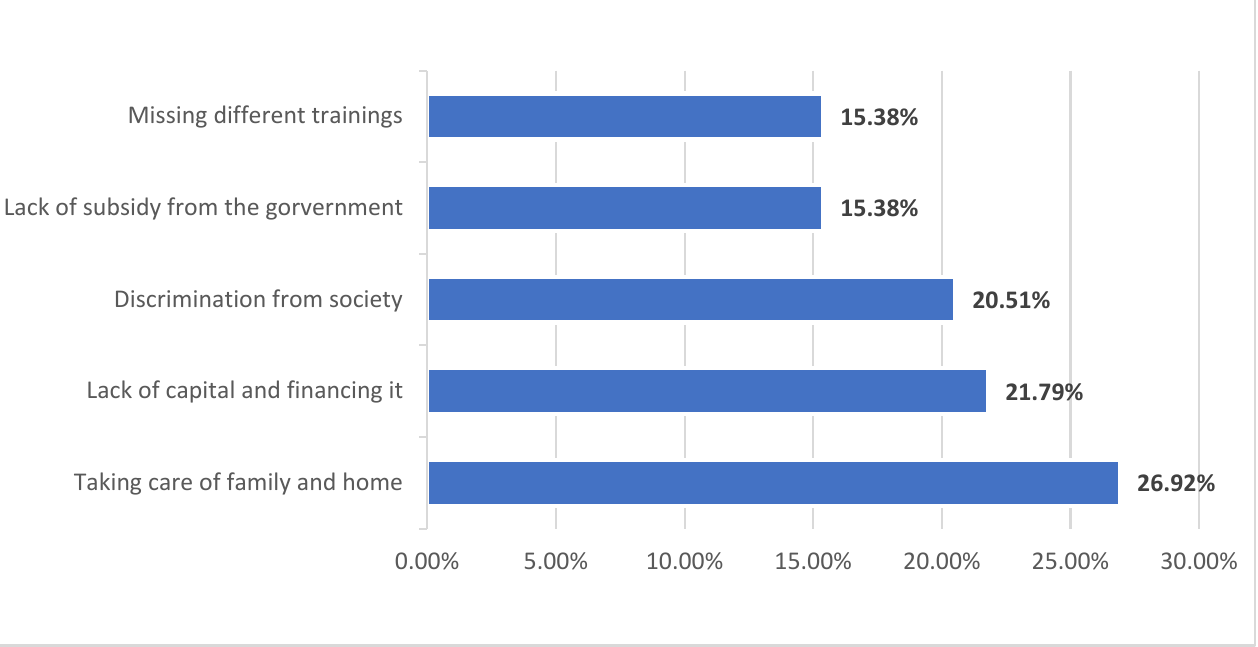
Figure 5. Barriers encountered (N = 36). Source: authors’ own elaboration.